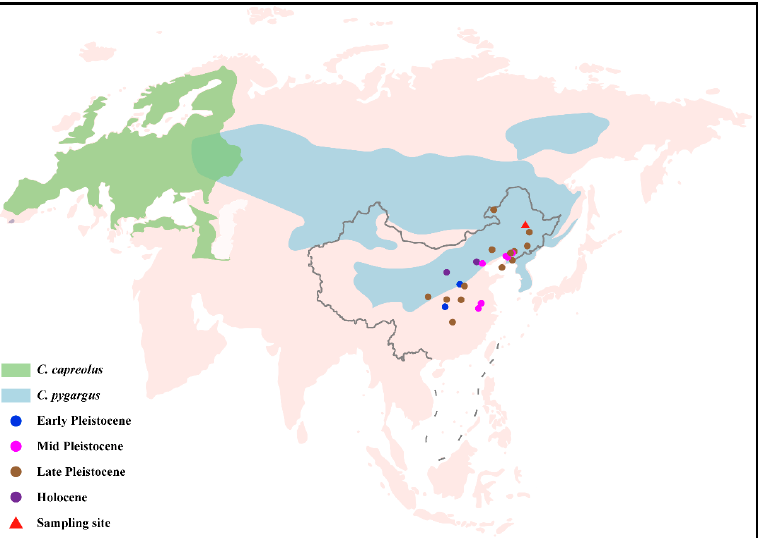
Figure 1. Distribution ranges of two roe deer species ( C. capreolus and C. pygargus ) [5]. The sampling site in this study is indicated by a red triangle. Other roe deer fossils are represented by dots in four different colors [17–22]. The base map of global world (chart no. GS (2016)1566) and China (chart no. GS (2019)1686) were downloaded from the National Administration of Surveying, Mapping